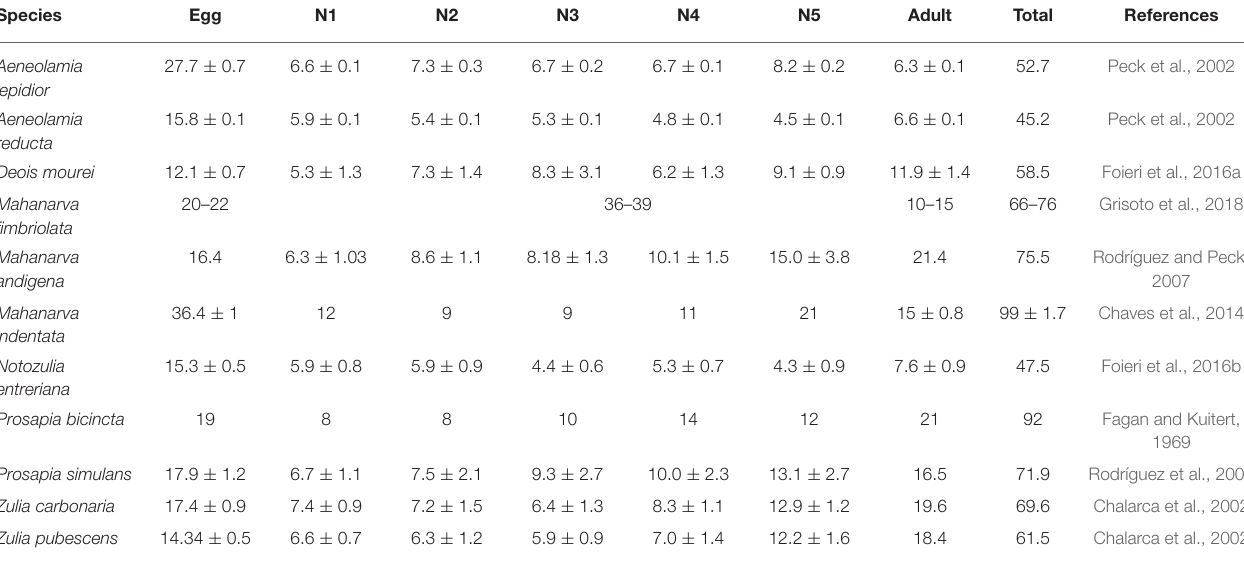
TABLE 2 | Duration of life cycle of different spittlebug species.